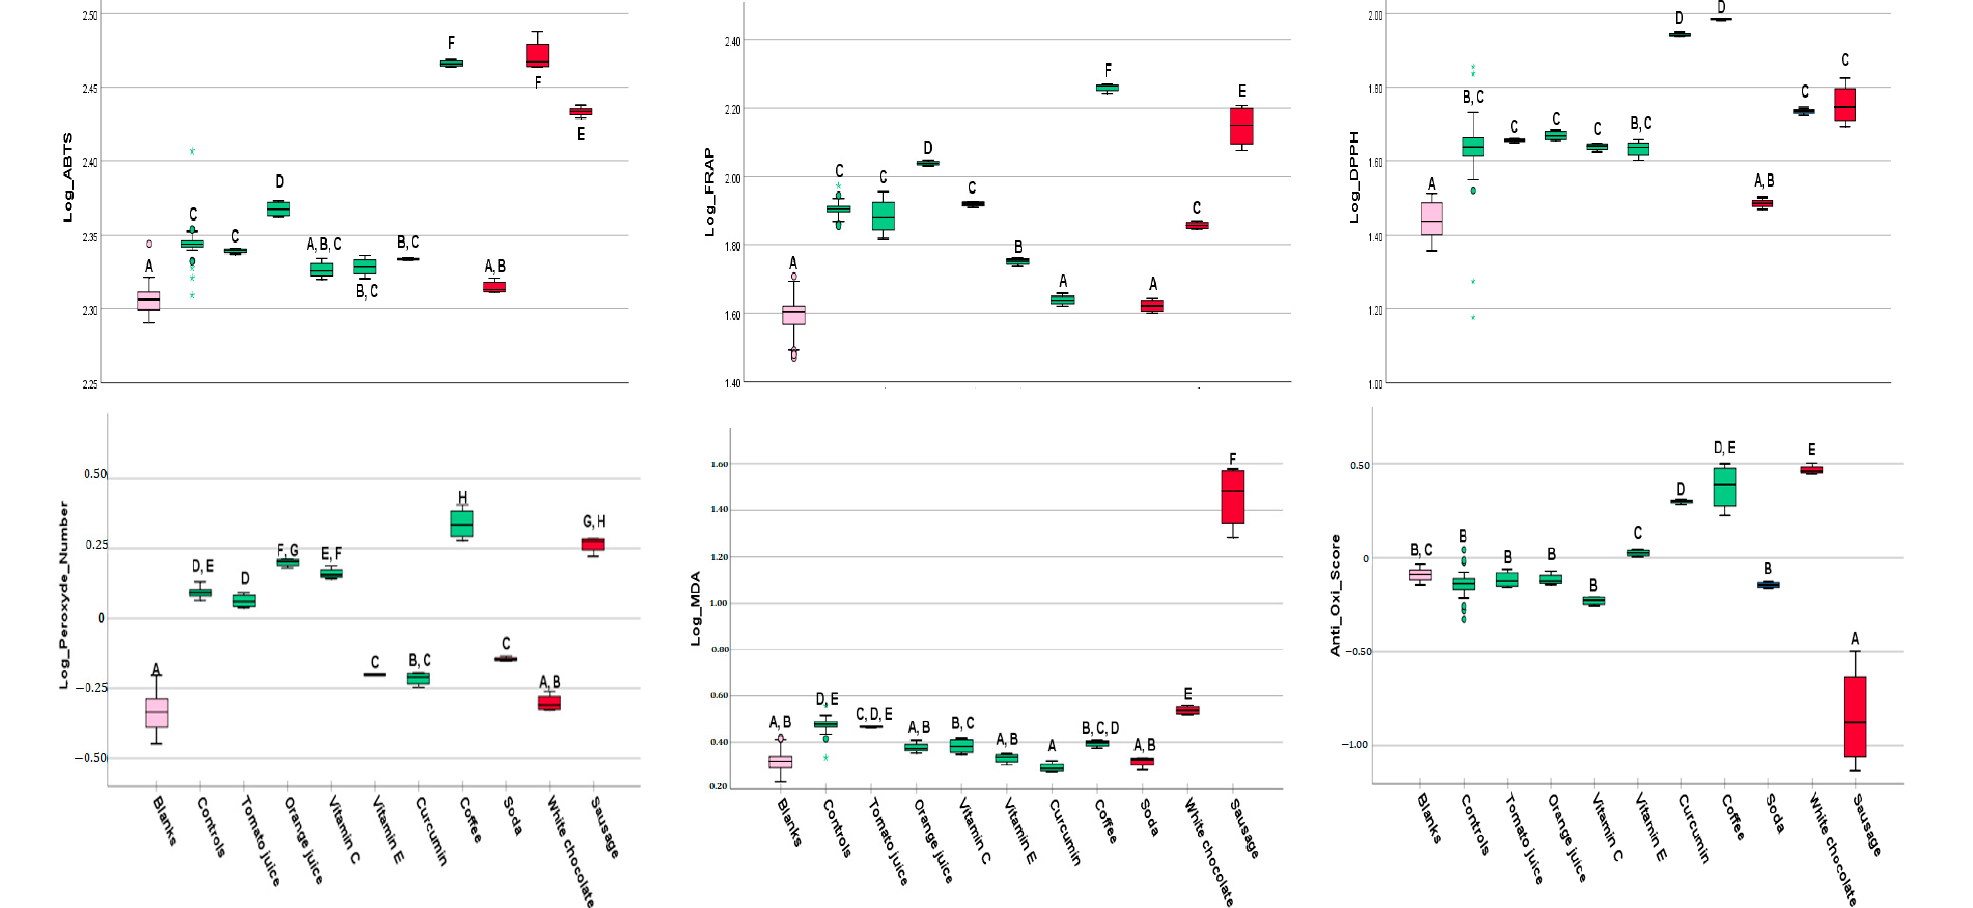
Figure 2. Multivariate analysis comparing antioxidant and pro-oxidant capacity of individual food items after in vitro digestion. Boxes not sharing the same superscript (capital letters) are statistically significantly different (Tukey’s post hoc test, p < 0.05). Log = All values are in logarithmic form. Pink color indicates the respective blank. Green colors represent presumably antioxidant-rich food items, red ones presumably pro-oxidant items.